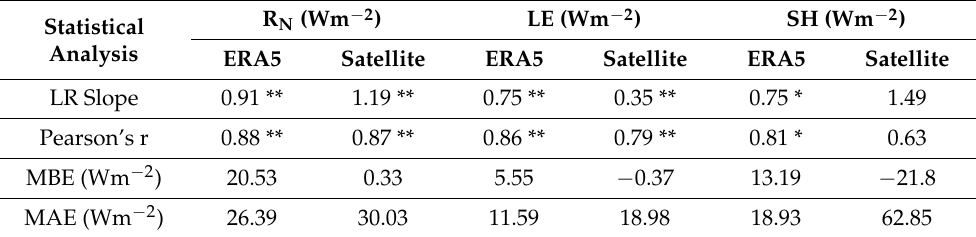
Figure 2. Correlation of satellite and ERA5 data with FluxNet observations. Red line describes the linear regression (LR) slope. Each black dot corresponds to a mean monthly value of surface energy budget (SEB) parameters measured in Wm − 2 . Table 3. Validation statistics of satellite and ERA5 data with respect to FluxNet observations. For LR slope and Pearson’s r; ** describe 99% significance while * describe 95% significance. Without * values are